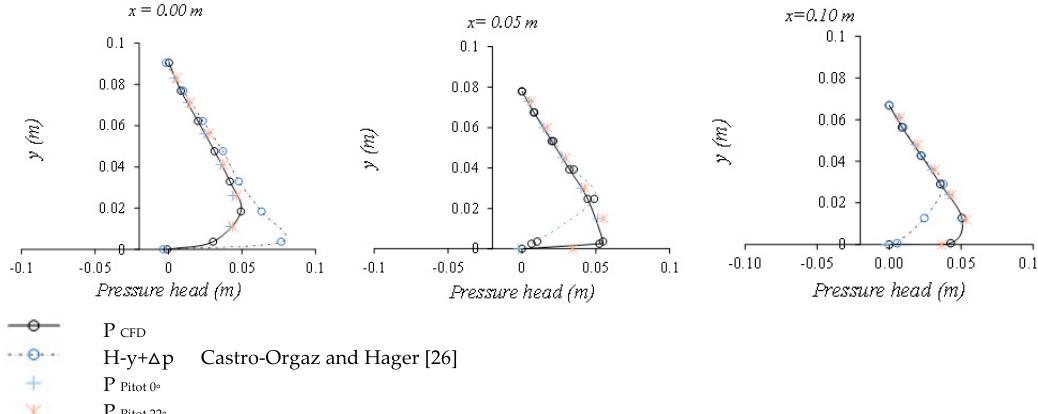
Figure 13. Pressure distribution along the flow calculated from PIV and Pitot measurements and simulated with CFD. Comparison with theoretical values.